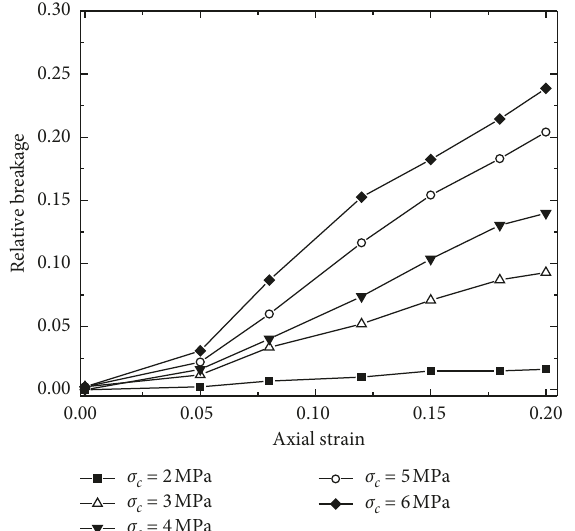
Figure 15: Relative breakage against axial